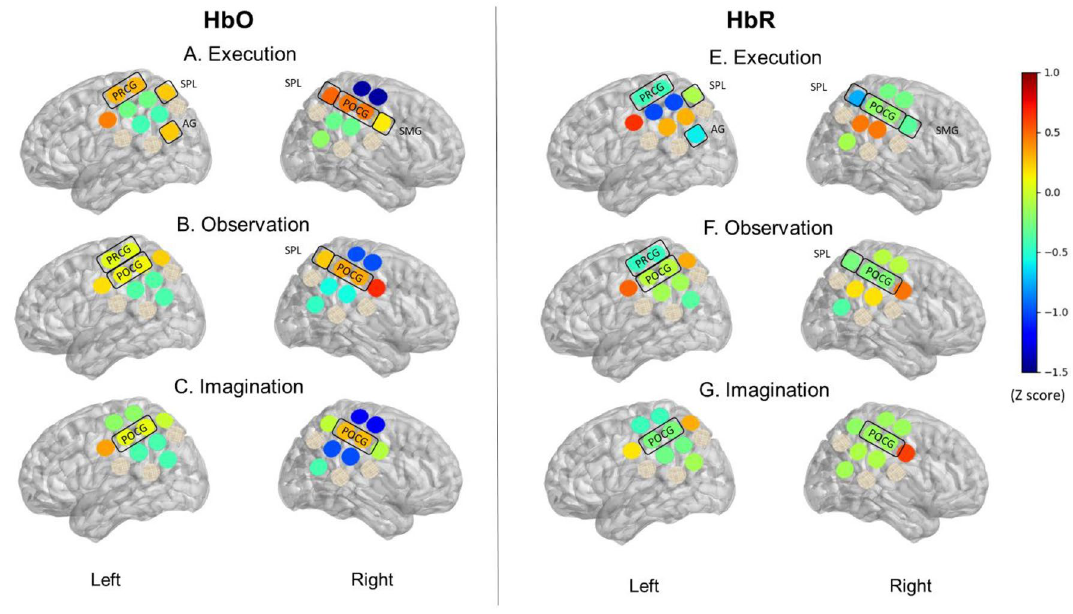
Figure 3. Unimodal fNIRS results. This is a visual representation of the HbO and HbR Z-scores during Execution (ME), Observation (MO), and Imagination (MI). HbO values on Y-axis range from − 1.5 indicated by cooler color (blue) to 0.1 indicated by warmer color (red). Highlighted regions indicate an increase in HbO and a decrease in HbR Z-scores. During ME, positive Z-scores for HbO and negative Z-scores for HbR were found in left PRCG, SPL, AG, and right POCG, SPL, SMG ( A , E ). During MO, positive HbO and negative HbR were found over Left PRCG, POCG, and right POCG, SPL ( B , F ). During MI, positive HbO and negative HbR were found in left and right POCG ( C , G